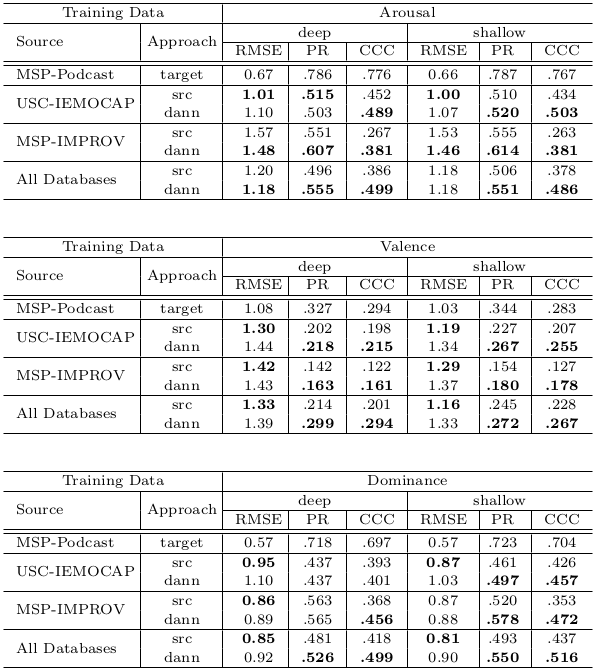
Table from the paper: Domain Adversarial for Acoustic Emotion Recognition
Table text:
TrainingData
Arousal
Source
Approach
deep
shallow
RMSE
PR
CCC
RMSE
PR
CCC
MSP-Podcast
target
0.67
.786
.776
0.66
.787
.767
USC-IEMOCAP
src
1.01
.515
.452
1.00
.510
.434
dann
1.10
.503
.489
1.07
.520
.503
MSP-IMPROV
src
1.57
.551
.267
1.53
.555
.263
dann
1.48
.607
.381
1.46
.614
.381
AllDatabases
src
1.20
.496
.386
1.18
.506
.378
dann
1.18
.555
.499
1.18
.551
.486
TrainingData
Valence
Source
Approach
deep
shallow
RMSE
PR
CCC
RMSE
PR
CCC
MSP-Podcast
target
1.08
.327
.294
1.03
.344
.283
USC-IEMOCAP
src
1.30
.202
.198
1.19
.227
.207
dann
1.44
.218
.215
1.34
.267
.255
MSP-IMPROV
src
1.42
.142
.122
1.29
.154
.127
dann
1.43
.163
.161
1.37
.180
.178
AllDatabases
src
1.33
.214
.201
1.16
.245
.228
dann
1.39
.299
.294
1.33
.272
.267
TrainingData
Dominance
Source
Approach
deep
shallow
RMSE
PR
CCC
RMSE
PR
CCC
MSP-Podcast
target
0.57
.718
.697
0.57
.723
.704
USC-IEMOCAP
src
0.95
.437
.393
0.87
.461
.426
dann
1.10
.437
.401
1.03
.497
.457
MSP-IMPROV
src
0.86
.563
.368
0.87
.520
.353
dann
0.89
.565
.456
0.88
.578
.472
AllDatabases
src
0.85
.481
.418
0.81
.493
.437
dann
0.92
.526
.499
0.90
.550
.516